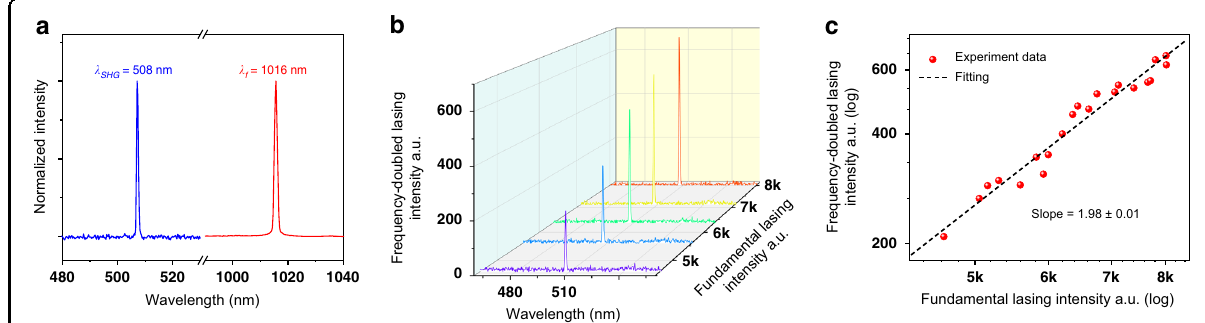
Fig. 3 Characteristic of the frequency-doubled lasing mode of the NW laser via the SHG process. a Normalized spectra of the fundamental lasing mode (1016 nm) and the frequency-doubled lasing mode (508 nm). b Emission spectra of the frequency-doubled lasing mode with the increasing fundamental lasing intensity. c Dependence of the fundamental lasing mode and the frequency-doubled lasing mode intensities, showing a fi tting slope 1.98 ± 0.01 on a log – log